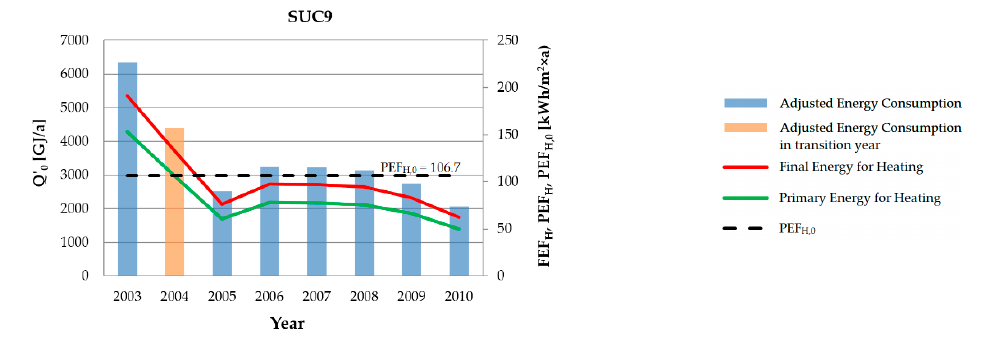
Figure 2. Presentation of changes of the Annual Adjusted Energy Consumption within the investigated period together with Final and Primary Energy Factor for Heating.